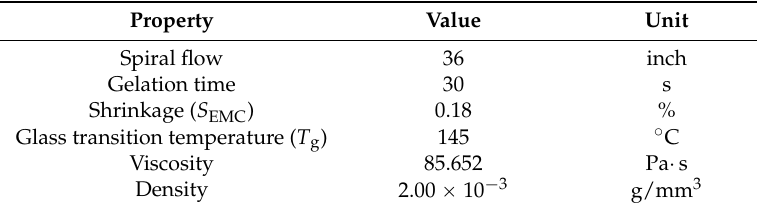
Table 2. Coefficient of thermal expansion (CTE) of molding components.